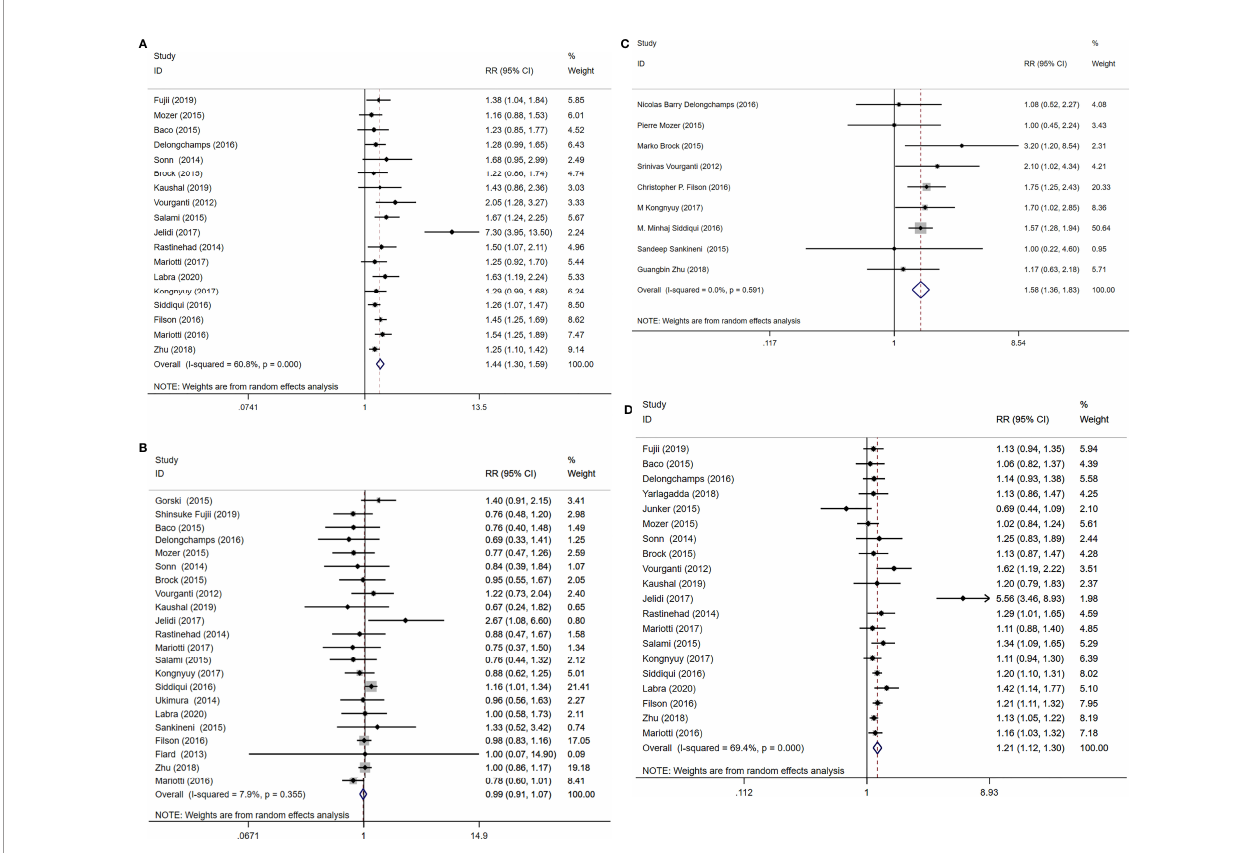
FIGURE 4 | MRI/Transrectal Ultrasound (TRUS) fusion guided-targeted biopsy (MRI-TB) Combined with systematic biopsy(SB) versus SB for the detection of (A) clinically signi fi cant prostate cancer, (B) clinically insigni fi cant prostate cancer, (C) high-risk prostate cancer, (D) overall prostate